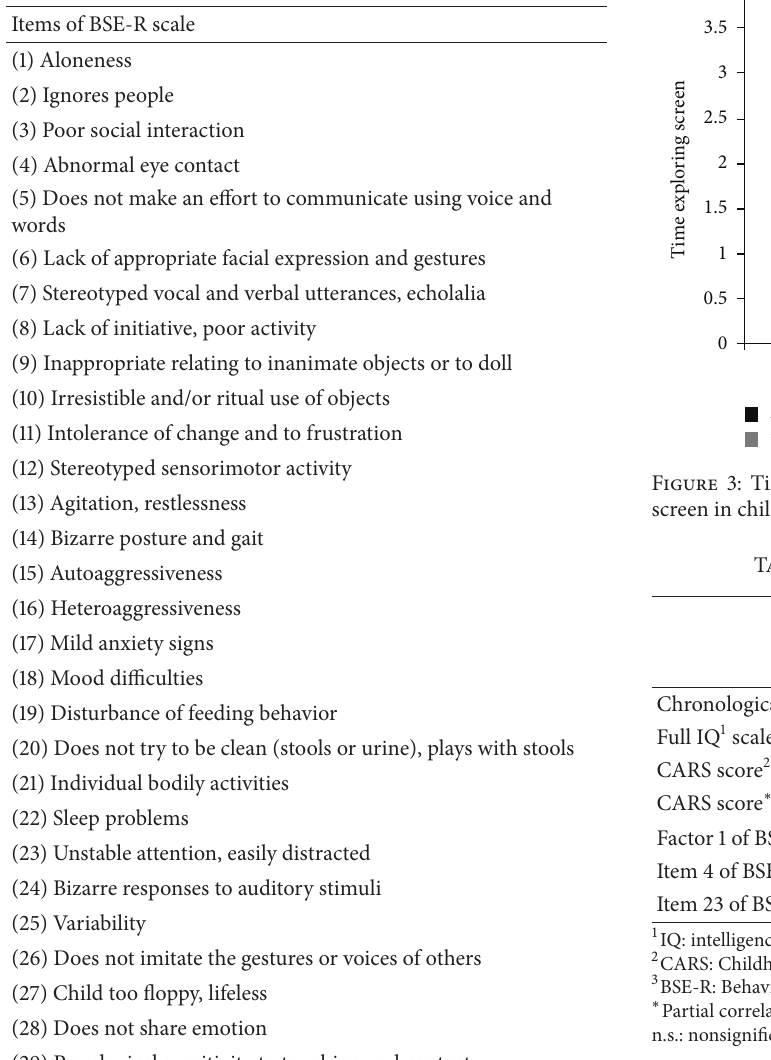
Table 1: Items of BSE-R scale.